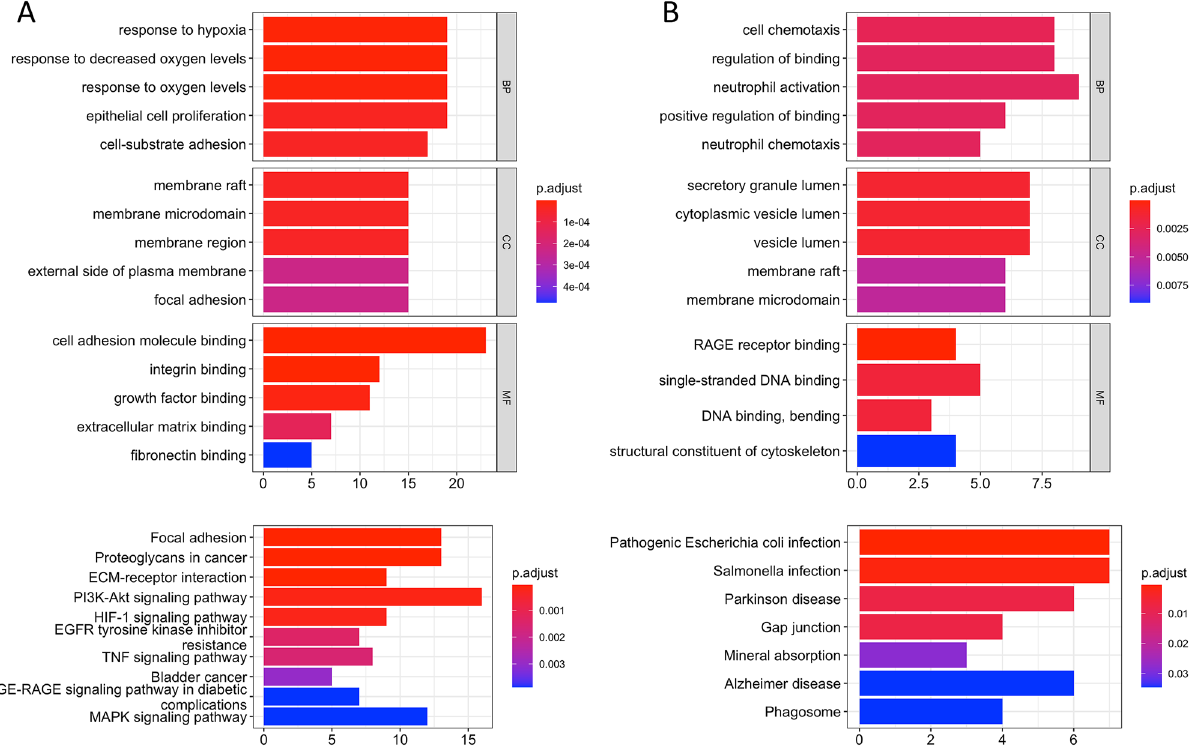
Figure 5. Kyoto Encyclopedia of Genes and Genomes and Gene Ontology enrichment analysis of Cluster-1 ( A ) and Cluster-3 ( B ). BP biological process, CC cellular components, MF molecular